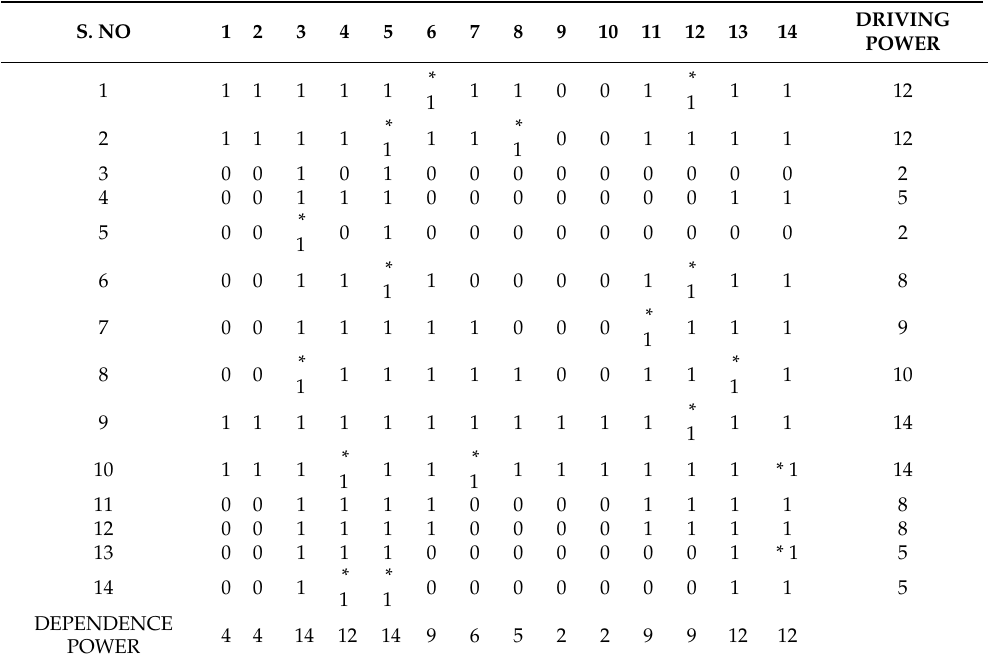
Table 4. Final reachability matrix